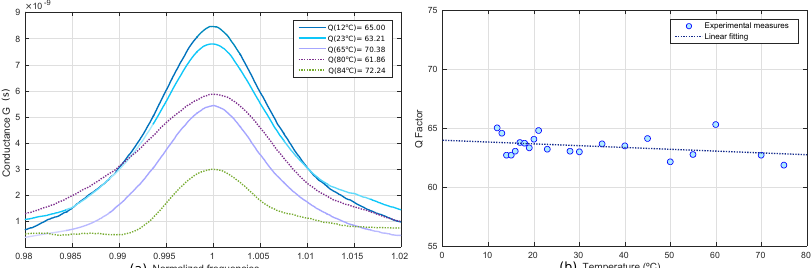
Figure 10. Experimental Q-factor with temperature scan for the prototype A 1 . ( a ) Experimental curves of the magnitude of the conductance normalized to the resonance frequency (at 23 ◦ C) obtained at different temperatures. ( b ) Q-factor obtained for the entire measured temperature range and the fitting for this range.